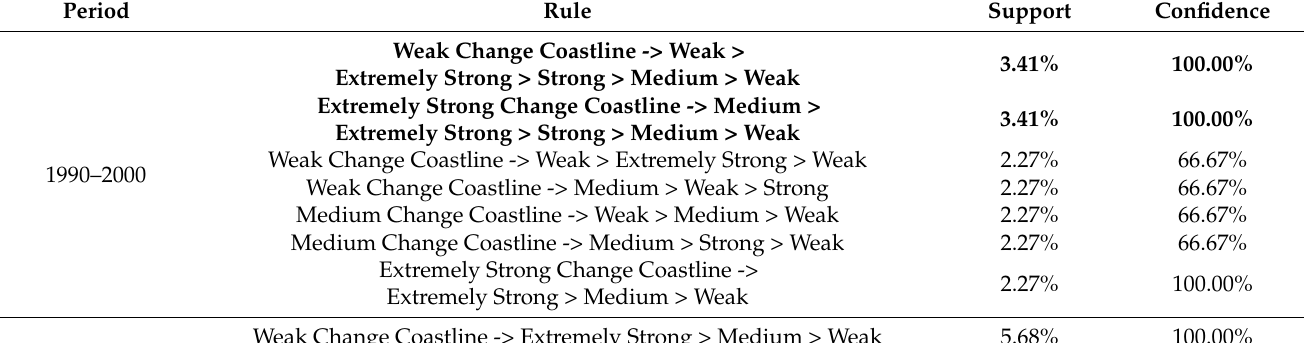
Table 3. Association rules between the coastline change and land development intensity in Qingdao.